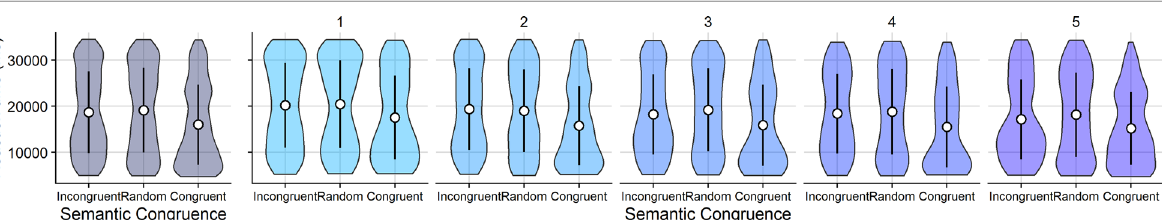
Fig. 9 Violin plots indicating reaction time in each semantic congruence condition (left, N Incongruent = 1467, N Random = 1464, N Congruent = 1463), and additionally for each experimental session (right, each violin plot is based on between 269 and 300 observations). White circles represent the mean and error bars represent ± 1 standard deviation